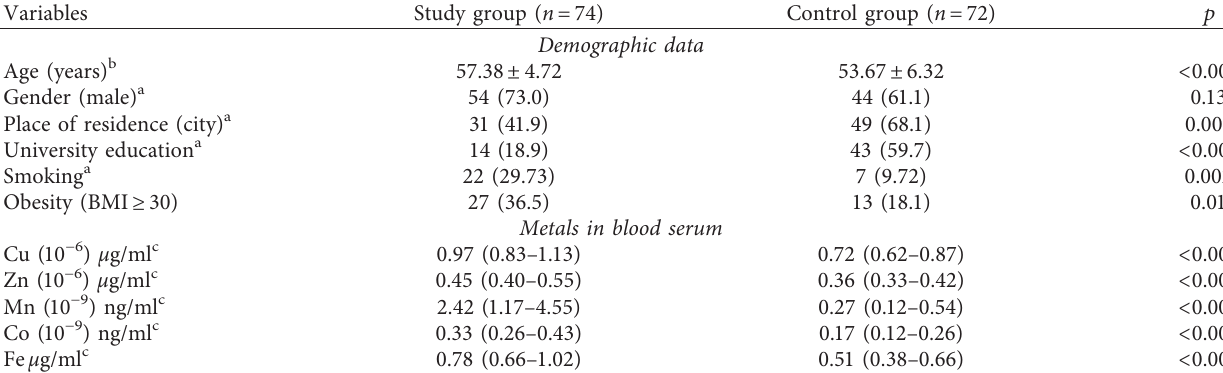
Table 1: Characteristics of the analyzed group.